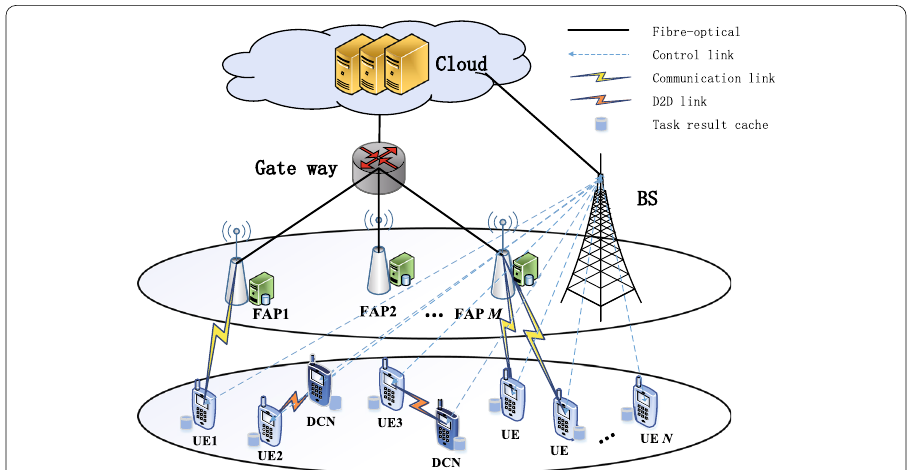
Fig. 1 Computing offloading in